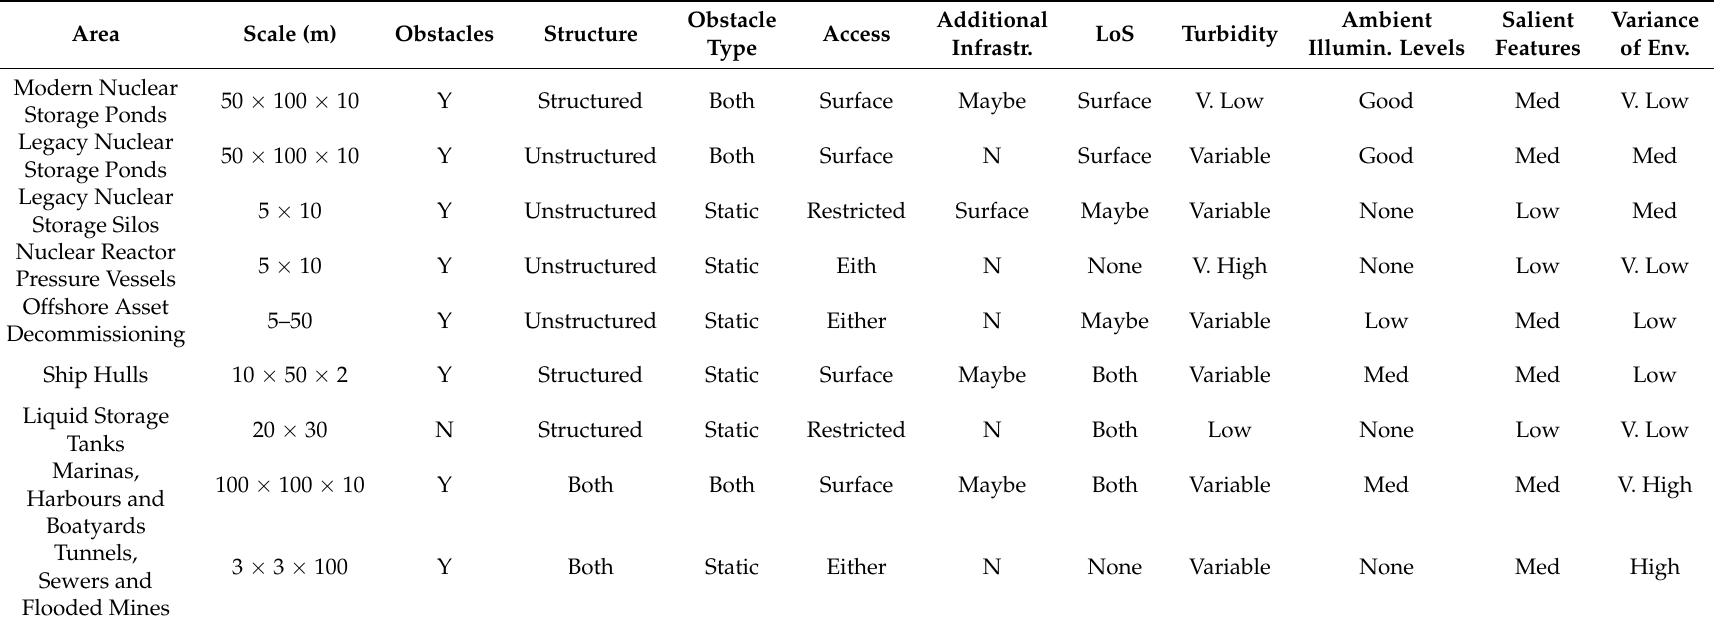
Table 1. Environmental Characteristics of Confined and Hazardous Application